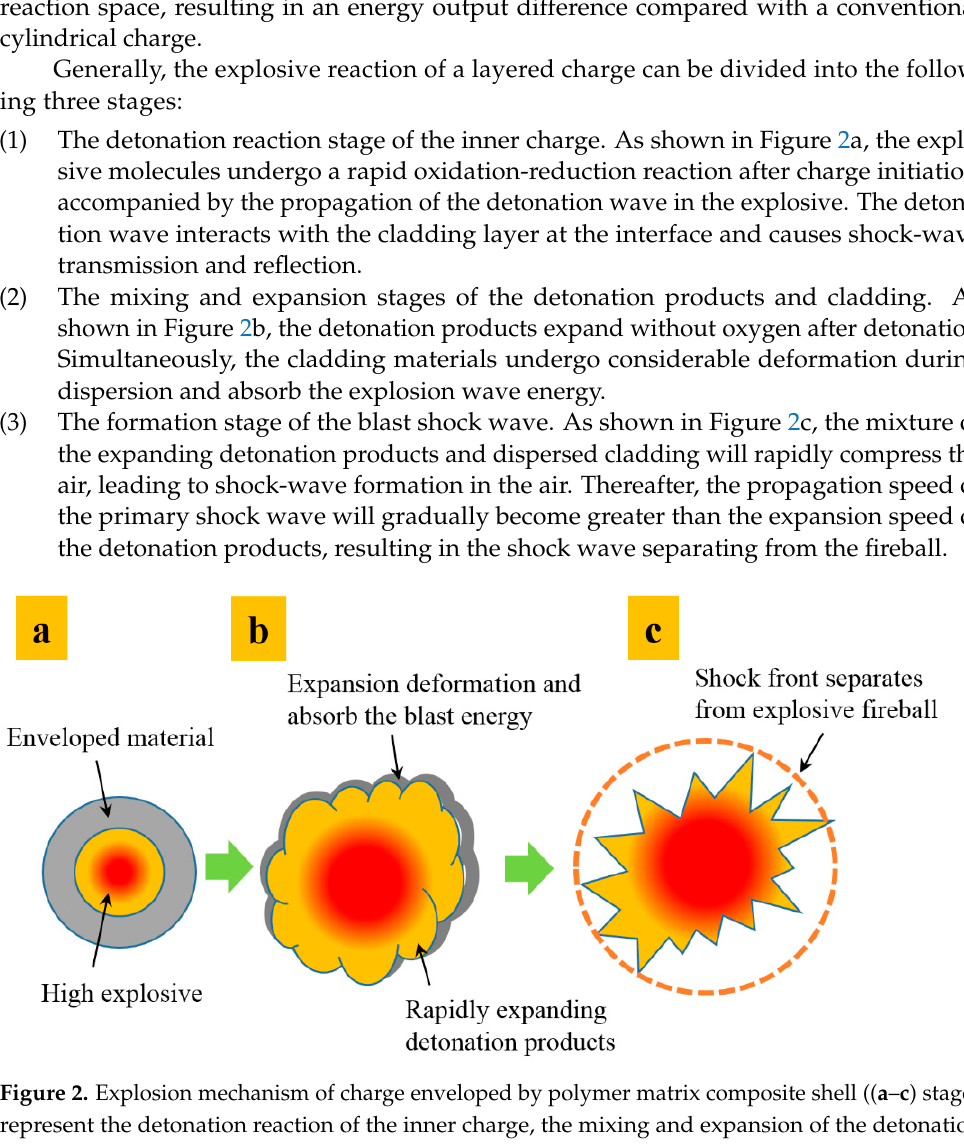
Figure 1. Structural diagram of a charge enveloped by a polymer matrix composite shell.